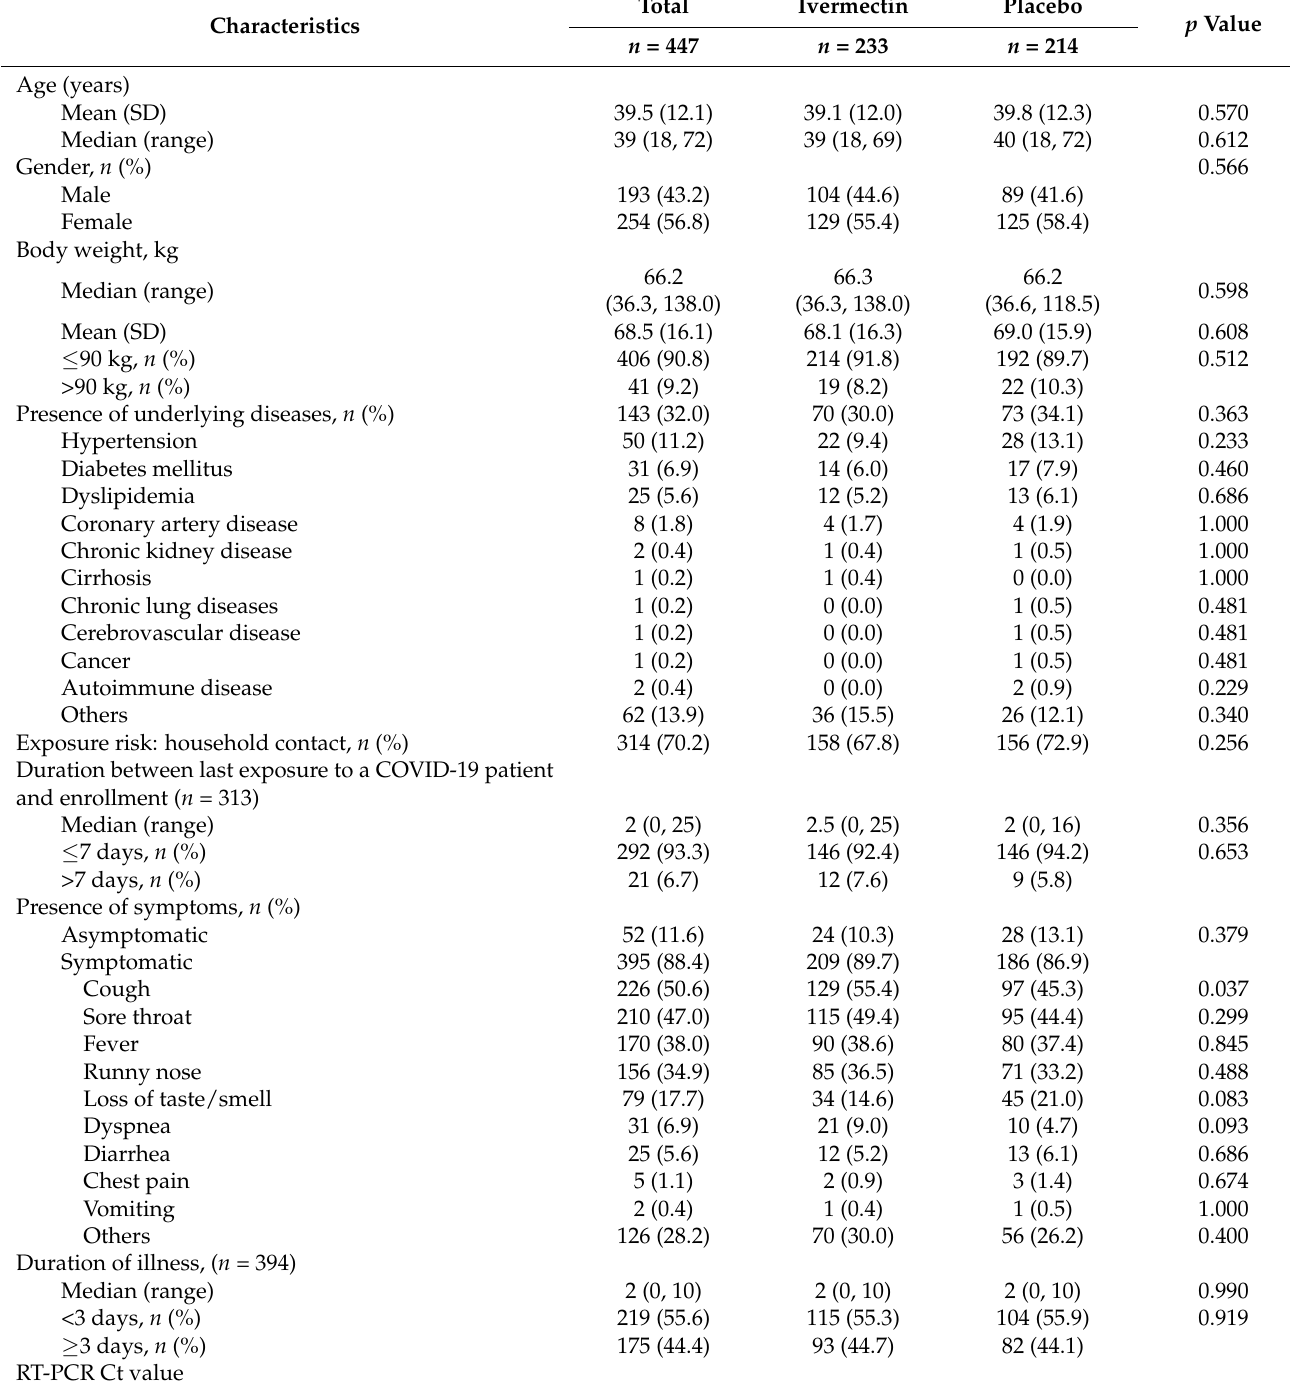
Table 3. Baseline characteristics of participants with a positive RT-PCR at enrollment in the ivermectin treatment